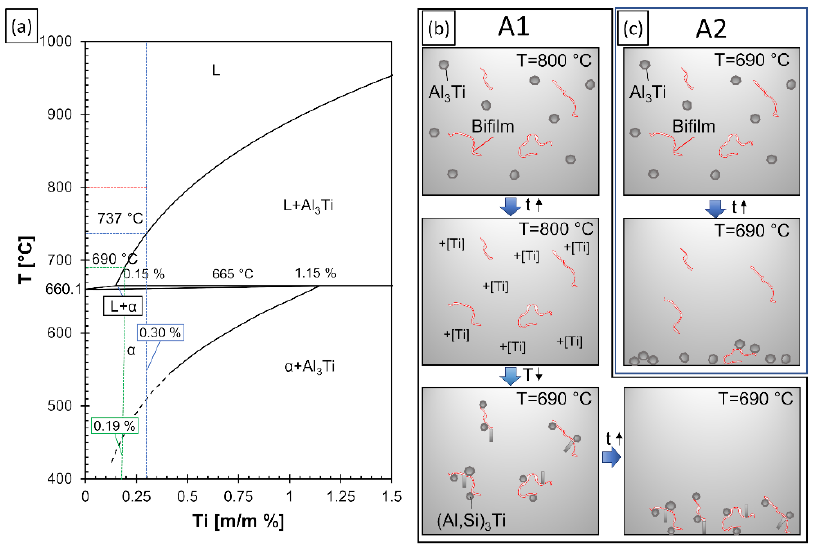
Figure 1. ( a ) The aluminum-rich section of the Al – Ti binary phase diagram (adapted from [69]), ( b , c ) schematic illustration of particle and bifilm settling during the experiments.